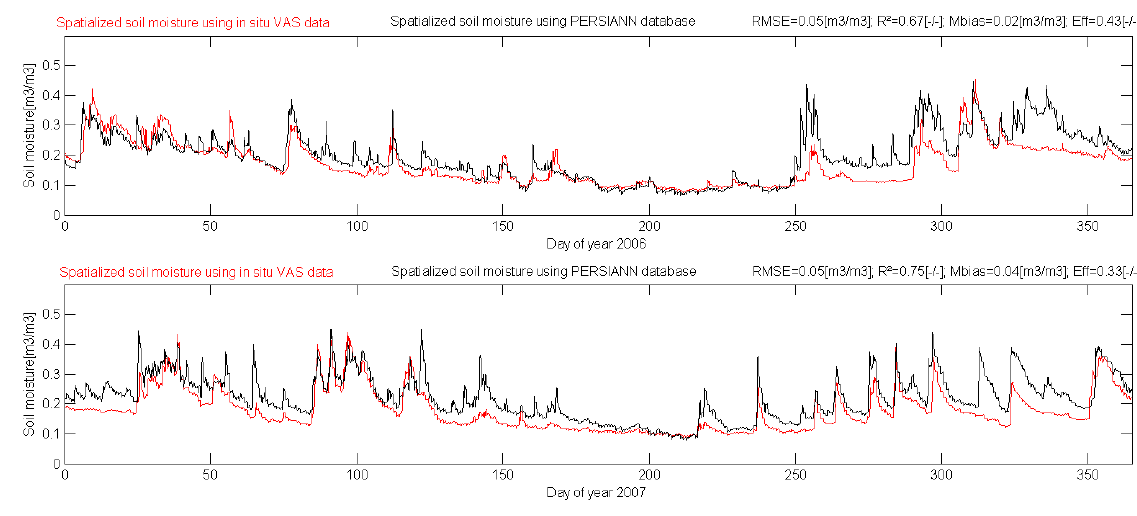
Fig. 7. Comparison between simulated soil moisture integrated over top 5 cm of soil using Caudete de las Fuentes rain gauge (blue line), Caudete de las Fuentes 1 rain gauge (red line) and the PERSIANN point PP148 (black line). The comparison is made for 2006 (upper figure) and 2007 (bottom figure).